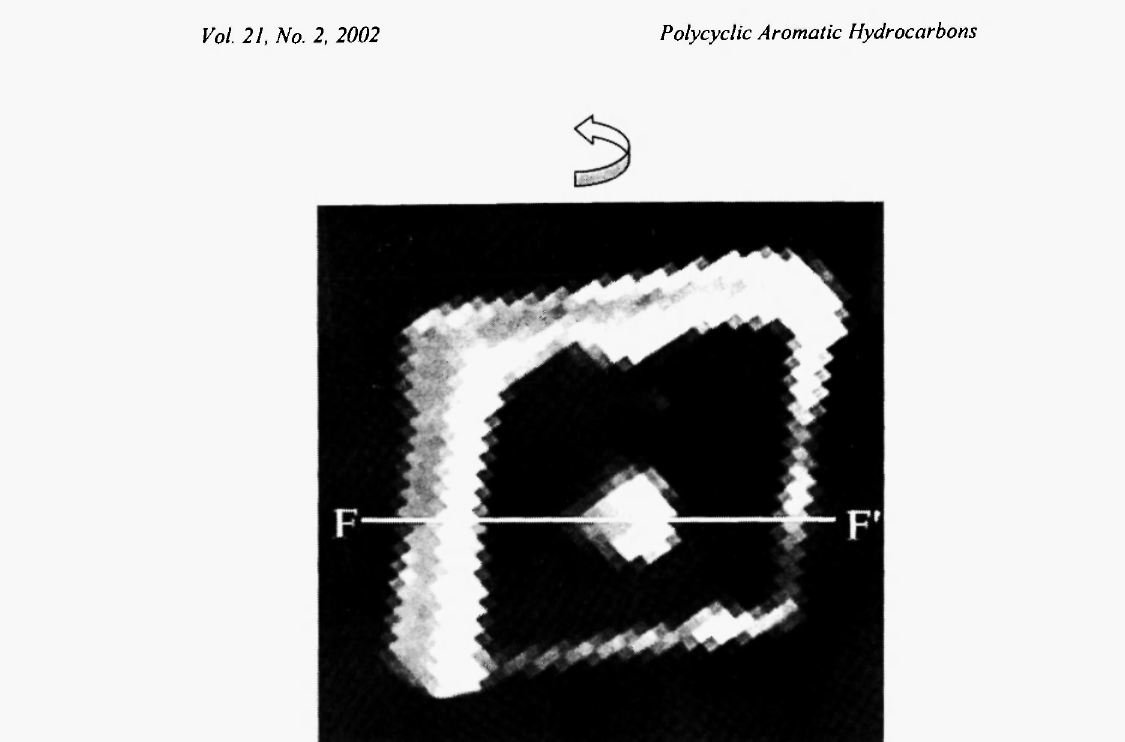
Fig. 19: A specified plane cut through (F-F) illustrated for a perylene crystal. The arrow indicates the rotation axis.